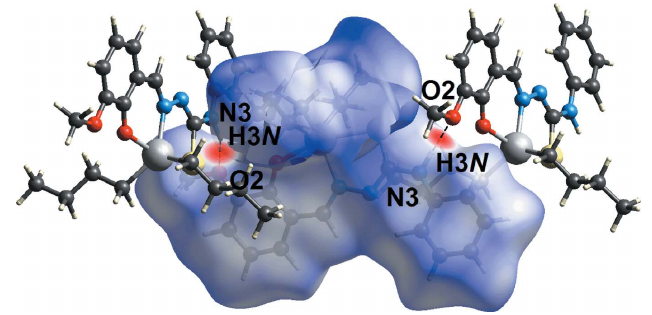
Figure 3 A view of the Hirshfeld surface for (I) mapped over d norm in the range (cid:6) 0.40 to +1.61 arbitrary units, highlighting red spots due to N3— H3 N (cid:2)(cid:2)(cid:2) O2 hydrogen bonds.